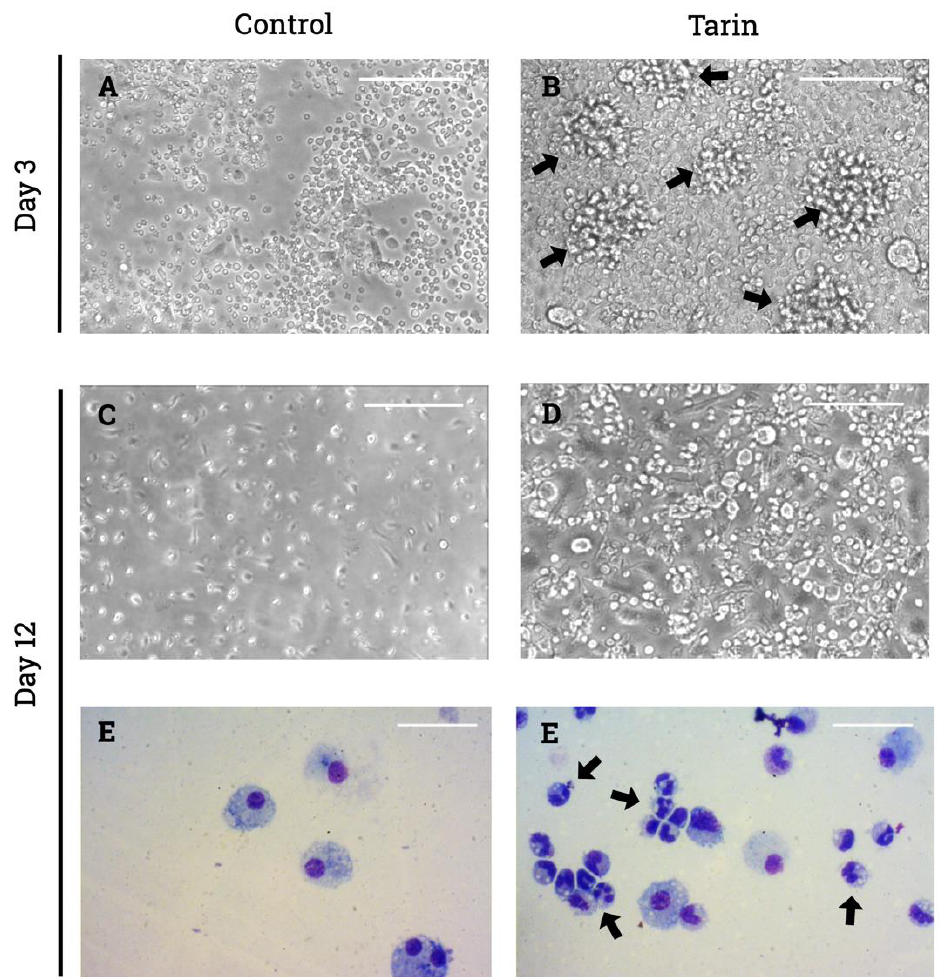
Figure 2. Representative photomicrographs of tarin-stimulated bone marrow cell cultures. Murine BM cells challenged with tarin at 25 µg/mL were cultured for 12 days and photomicrographs were acquired on the 3rd ( B ) and 12th ( D , F ) days post-stimulation. Photomicrographs of non-stimulated cultures cells were acquired on the 3rd day ( A ) and 12th day ( C , E ). Arrows indicate clusters/colonies ( B ) and neutrophils ( F ). Photomicrographs were acquired using an inverted-phase microscope at 200× ( A – D ) or a vertical microscope at 400× ( E , F ) magnification.